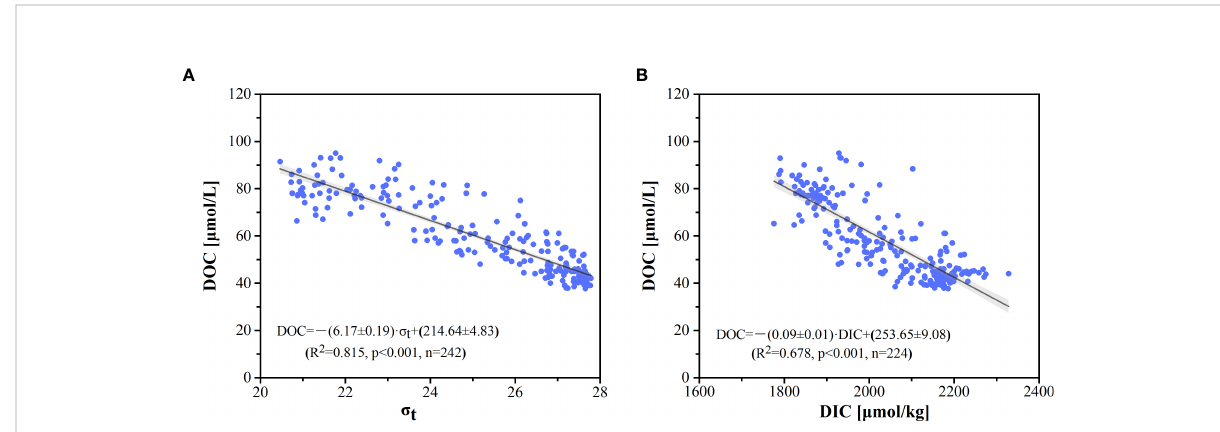
FIGURE 7 Scatterplots of (A) DOC concentrations vs. density ( s t ) and (B) DOC concentrations vs. DIC concentrations during the three cruises in the northern SCS and western NP. The solid lines and equations in both plots illustrate the trends of the relationship. The gray areas mark the 95% con fi dence interval of the linear regression. (A) DOC concentrations and the density for all 27 stations were from this study and a previous study; in panel (B) , the DIC concentrations were measured at only 25 stations, excluding 2A1 and A10 (Ding et al., 2020 and other unpublished